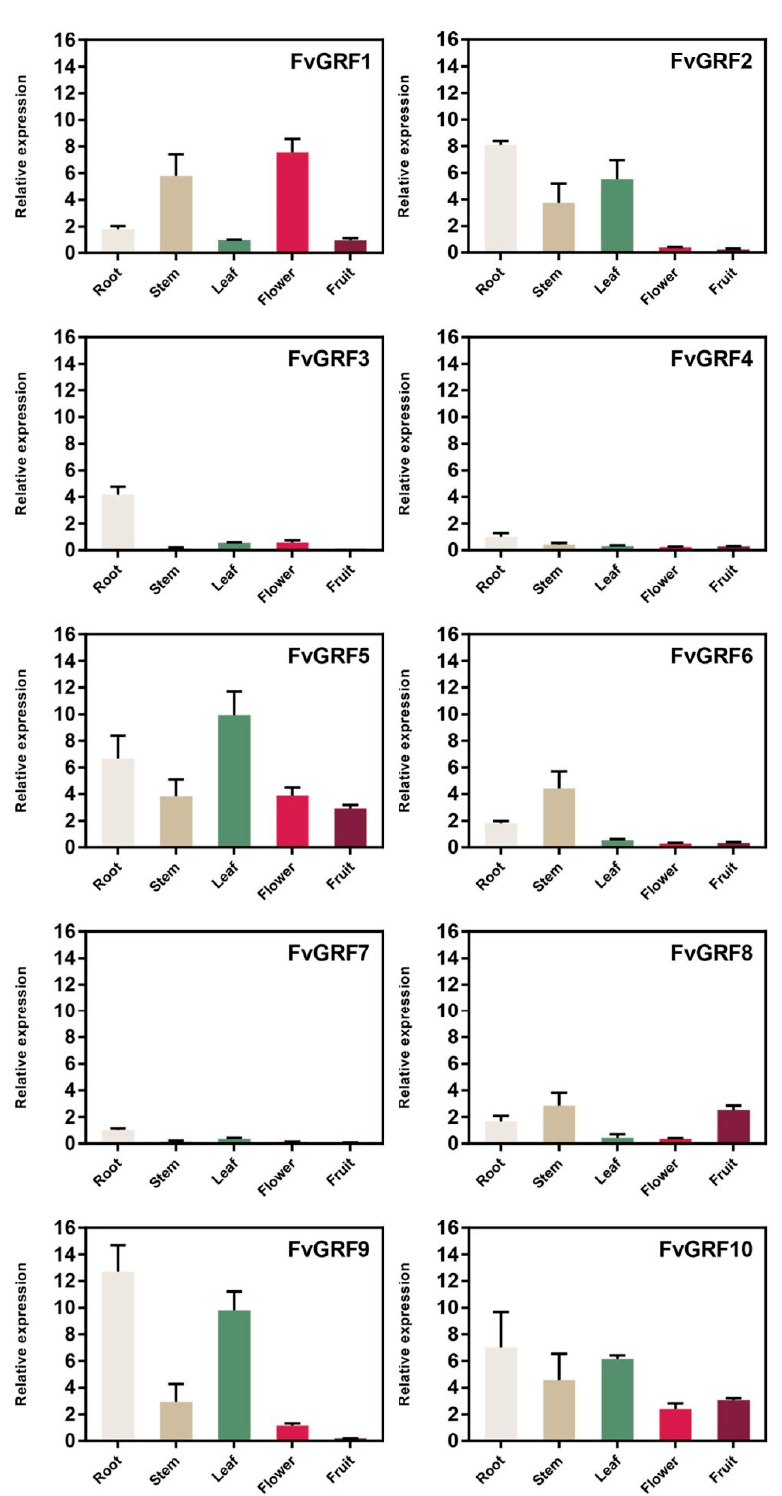
Figure 3. Quantitative RT-PCR analysis of 10 FvGRF genes in different organs of woodland strawberry. Roots, stems, and leaves are sampled during the period of vigorous growth, 42 days after the flowers are sampled, and the fruits are sampled 26 days after the flowers. Expression levels were normalized to that of FvPDB . The experiment was repeated three